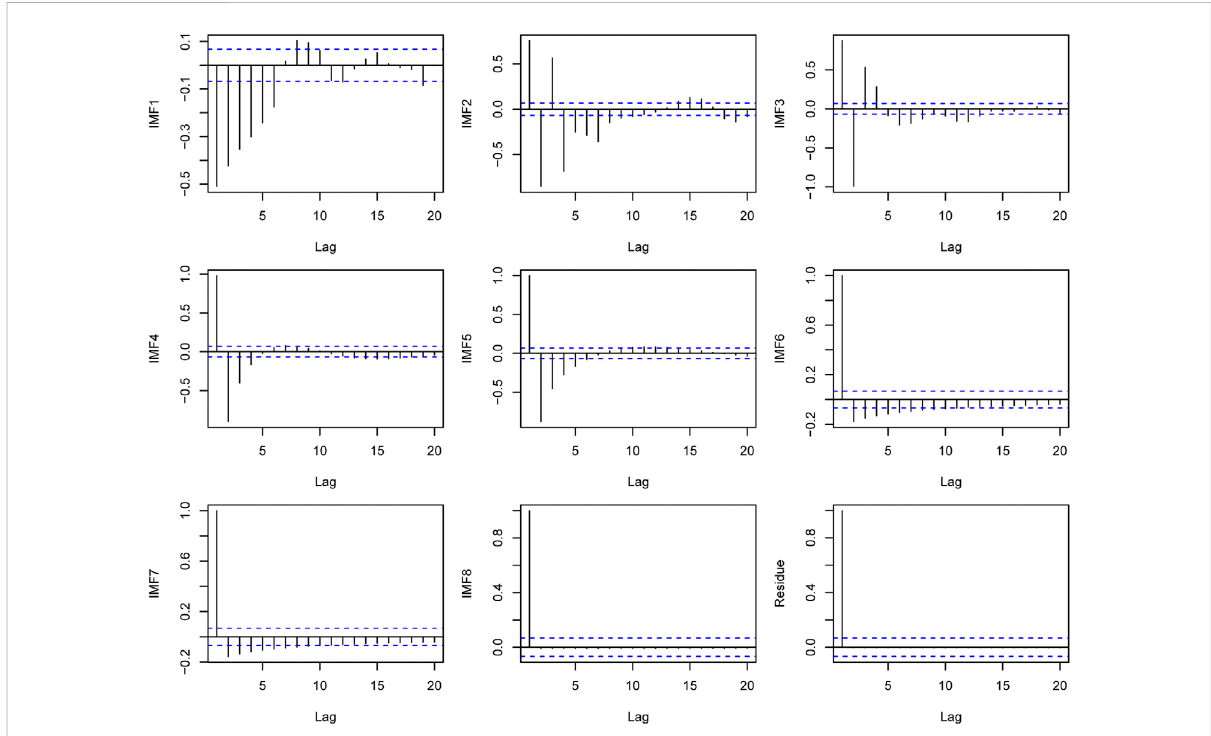
FIGURE 6 The PACF plots for the decomposition results of Kunming